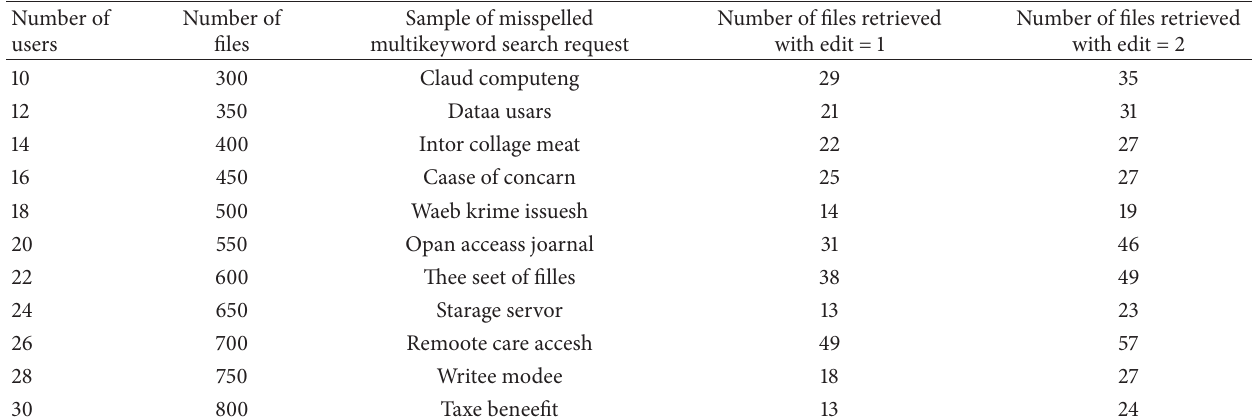
Table 3: Analysis of data utilization efficiency for misspelled keywords.